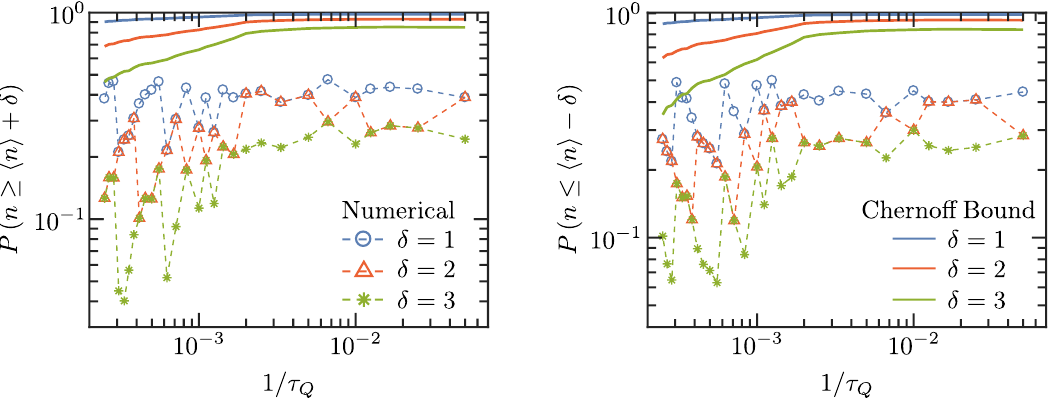
Figure 11 . The bound of the upper tail (Left) and lower tail (Right) of distributions of vortex numbers as a function of the inverse of quench time. Numerical results satisfy the theoretical bounds, that capture the dependence on the quench